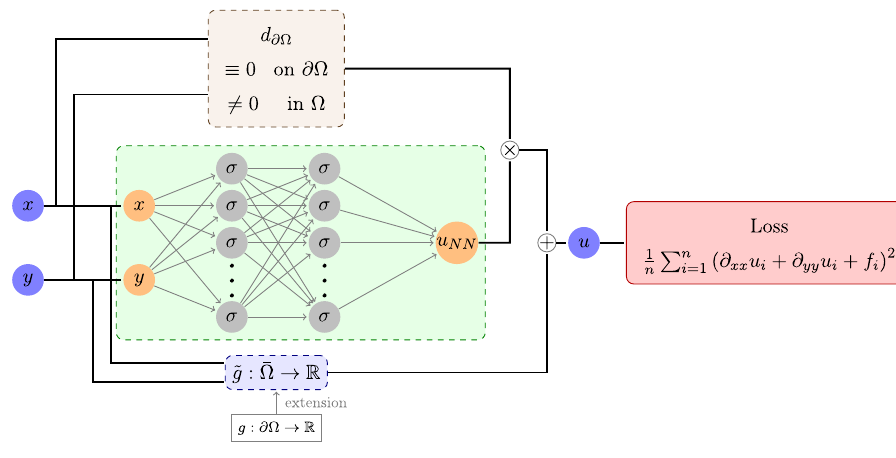
Fig. 1 Section 3.3: Diagram of our ansatz u = d 𝜕 Ω ⋅ u NN + ̃ g for the two dimensional Poisson problem. Here we used the abbreviations u i ∶= u ( x i , y i ) and